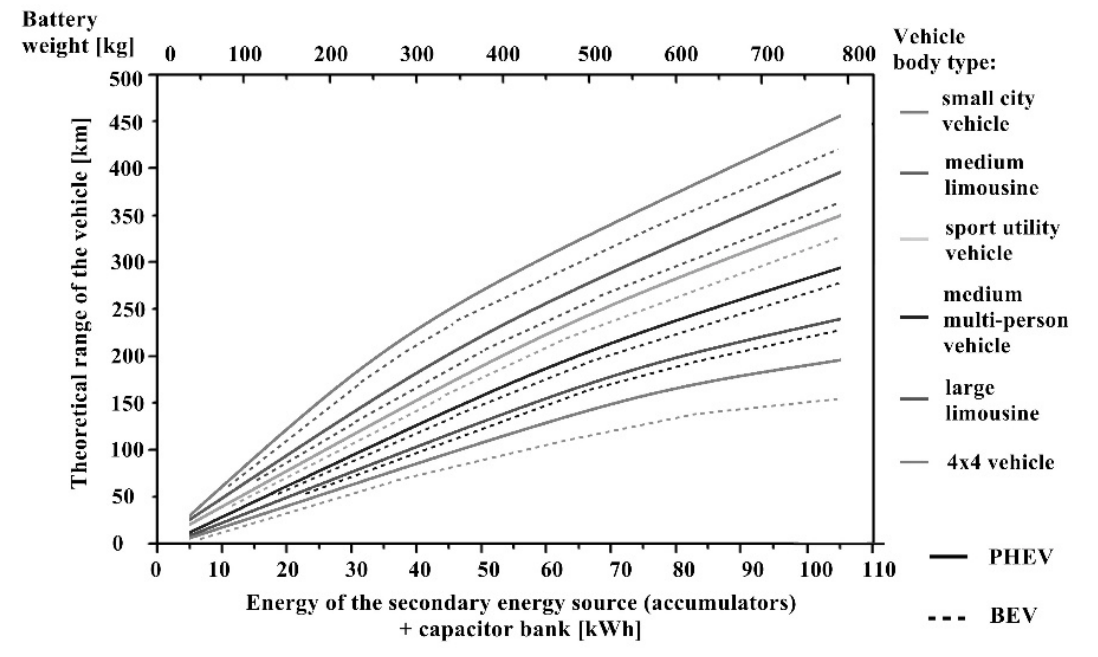
Figure 5. Energy demand depending on various vehicle body types, the weight of batteries, and a theoretical range of PHEVs and BEVs.